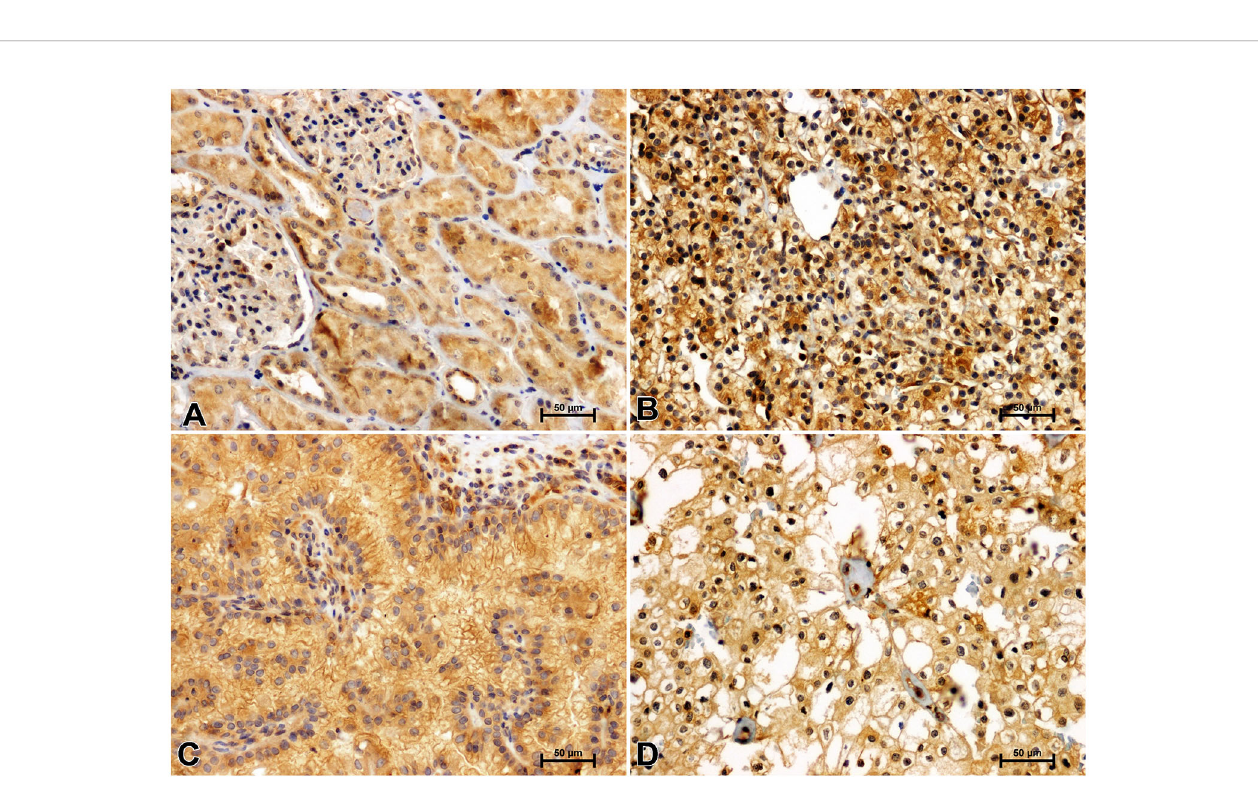
FIGURE 4 | Immunolabeling of GSK-3ß in non-malignant kidney (A) and clear cell RCC (B) , papillary RCC (C) , chromophobe RCC (D) .